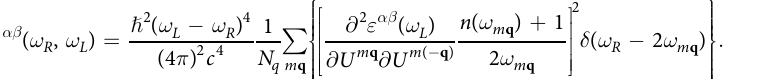
Figure 4. Second-order Raman spectrum obtained by differentiating the dielectric constant (at ω = 0 obtained within density-functional perturbation theory. “Full” means that the emission of all possible phonon pairs are considered in the calculation, while for the “overtone” graph, only the emission of time-reversed phonon pairs are taken into